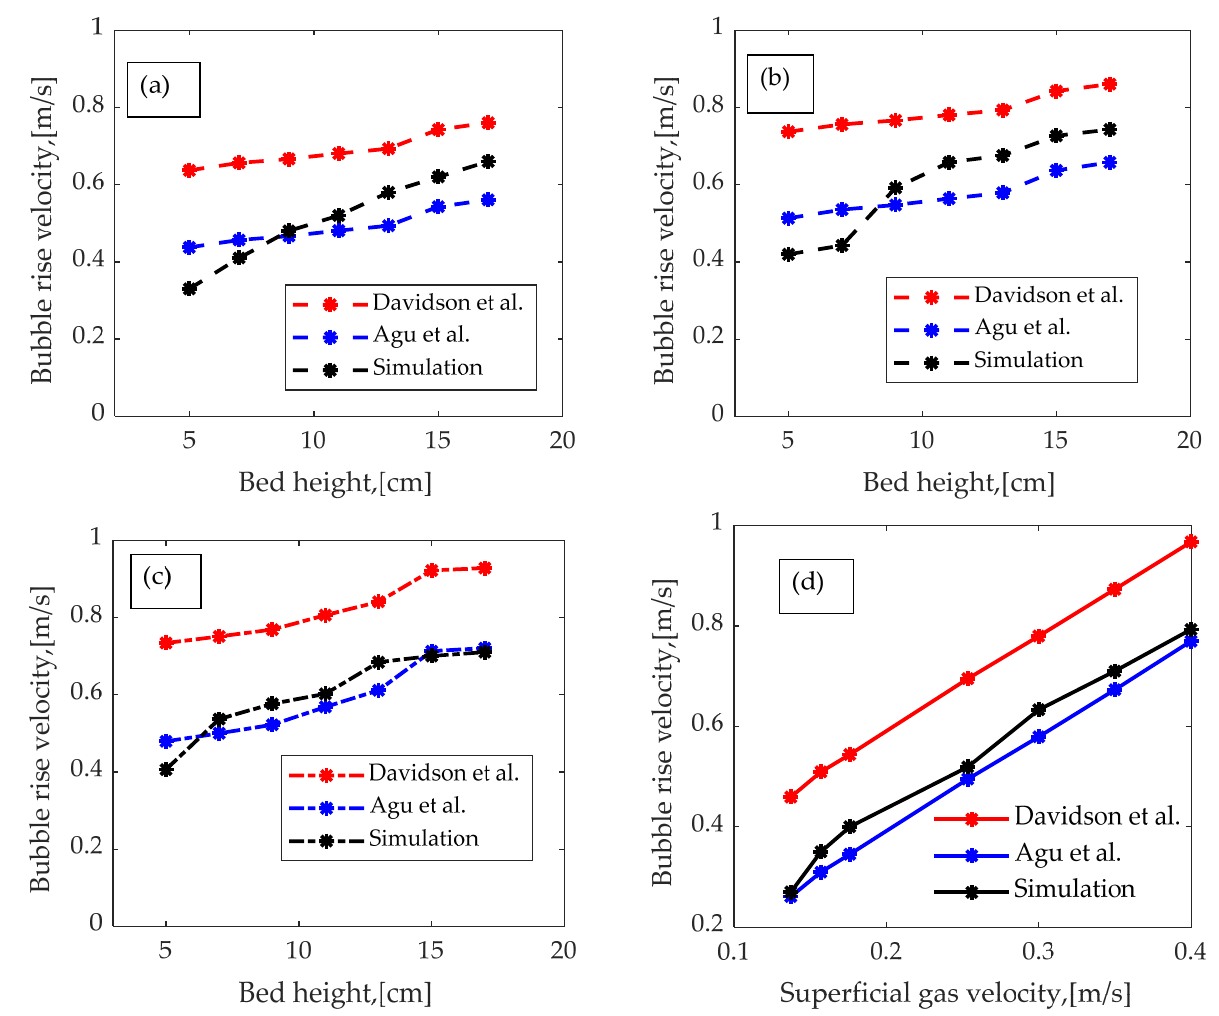
Figure 9. ( a – c ) Bubble rise velocity vs. bed height at different gas velocities of 0.13 m/s, 0.35 m/s, and 0.4 m/s, respectively; ( d ) average bubble rise velocity as the bubbles moved from the plane at 10 cm to the plane at 15.7 cm at different superficial fluidizing gas velocities.